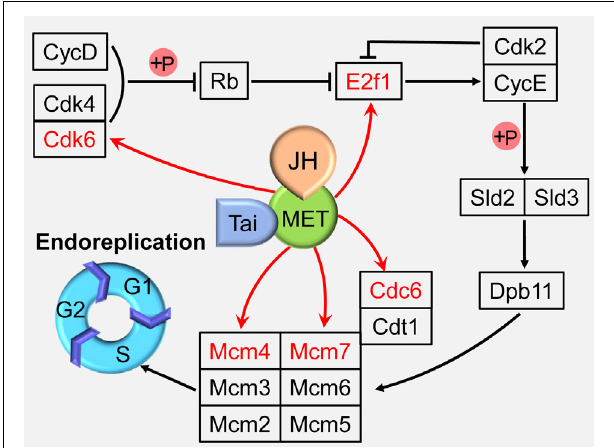
FIGURE 2 | Juvenile hormone (JH) regulation of the endoreplication. JH-Met/Tai ligand-receptor complex directly activates the expressions of cell cycle genes including minichromosome maintenance proteins 4 and 7 (Mcm4 and 7), cell division cycle 6 (Cdc6), cyclin-dependent kinase 6 (Cdk6), and adenovirus E2 factor-1 (E2f1) to regulate endoreplication and cell polyploidy. Met, Methoprene-tolerant; Tai, Taiman; CycD, cyclin D; Cdk2 and 4, Cyclin-dependent kinase 2 and 4; Rb, retinoblastoma; CycE, cyclin E; Cdt1, Cdc10 protein-dependent transcript 1; Mcm2, 3, 5, and 6, minichromosome maintenance protein 2, 3, 5, and